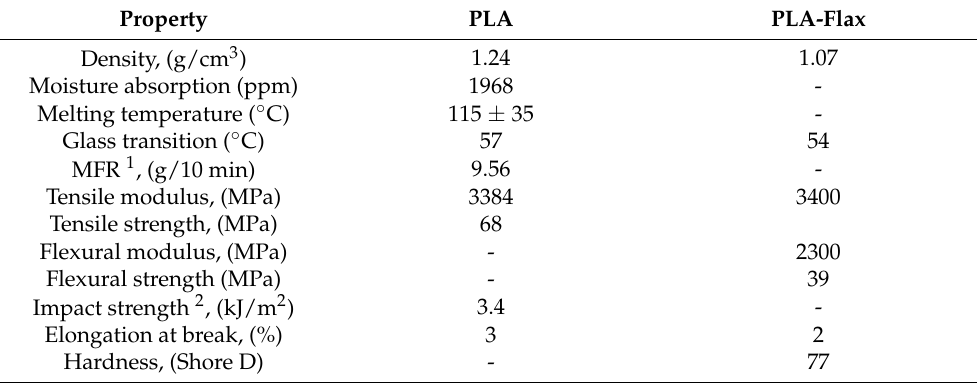
Table 1. Properties of considered feedstock materials